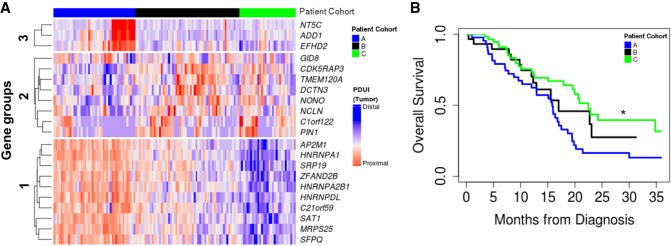
APA events identify a poor prognostic cohort in PDAC patients. (A) Patients were clustered based on 3′-UTR short (red) and long forms (blue) of 3′-UTR-altered genes (clustered into gene Groups 1, 2, and 3) and segregated into patient Cohort A (blue), patient Cohort B (black), and patient Cohort C (green). (B) Kaplan–Meier survival plot for patient Cohort A (blue), patient Cohort B (black), and patient Cohort C (green): (*) P < 0.05.